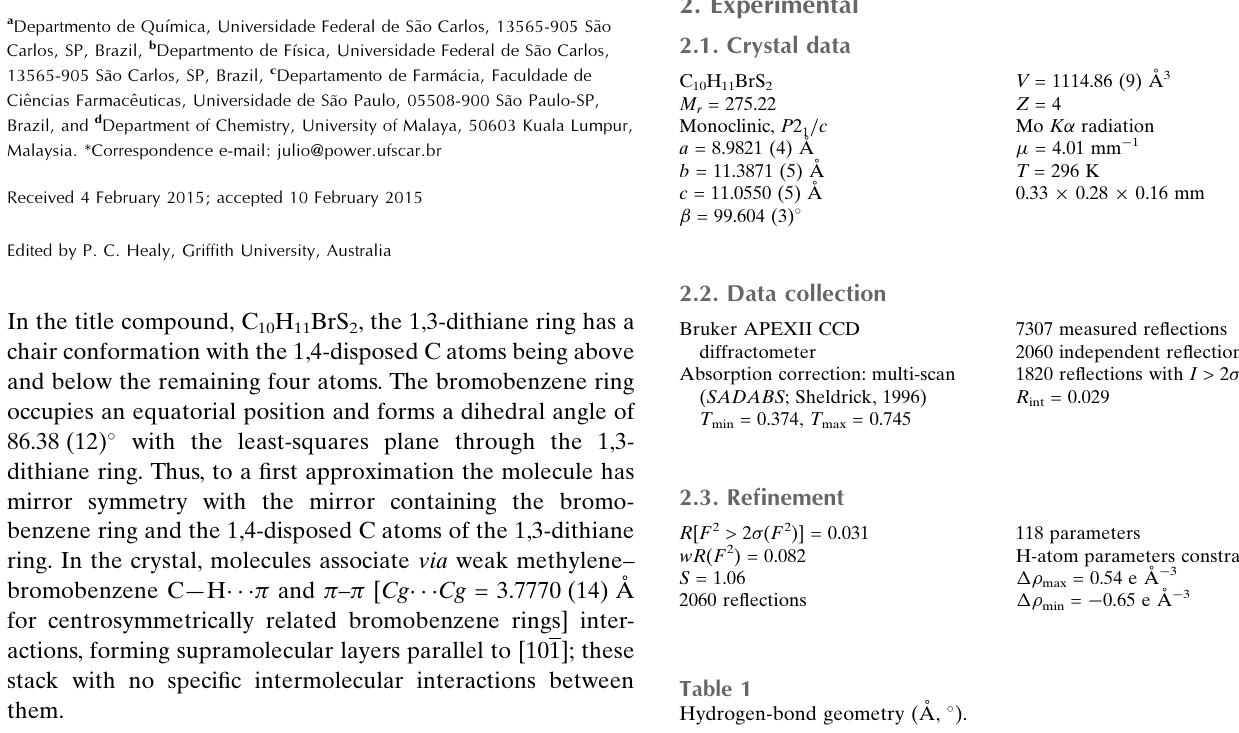
Hydrogen-bond geometry (A˚ , (cid:2)